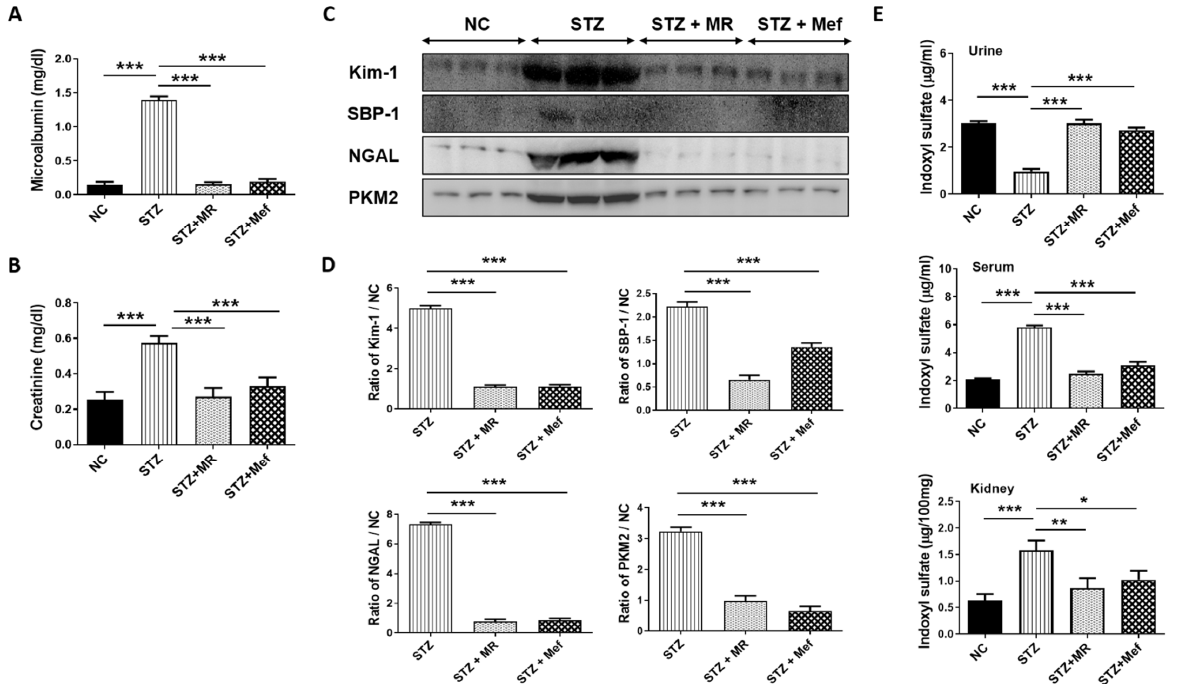
Figure 2. Effects of MR extract administration on biochemical and urinary parameters in STZ-induced diabetic rats. Alteration of ( A ) Urinary excretion of microalbumin and ( B ) serum creatinine level. Values are the mean ± S.D. ( n = 6). Statistical evaluation was achieved by one-way ANOVA subsequently by Tukey’s HSD post hoc test for multiple comparisons (*** p < 0.001). ( C ) The expression pattern of kidney damage biomarkers (KIM-1, SBP-1, NGAL, and PKM2) in the urine. ( D ) The band intensity was evaluated densitometrically using ImageJ software (*** p < 0.001). ( E ) Alteration of 3-indoxyl sulfate concentration in STZ-treated rats in the urine, serum, and kidney tis- sues was quantified by high-performance liquid chromatography (HPLC). Values are the mean ±